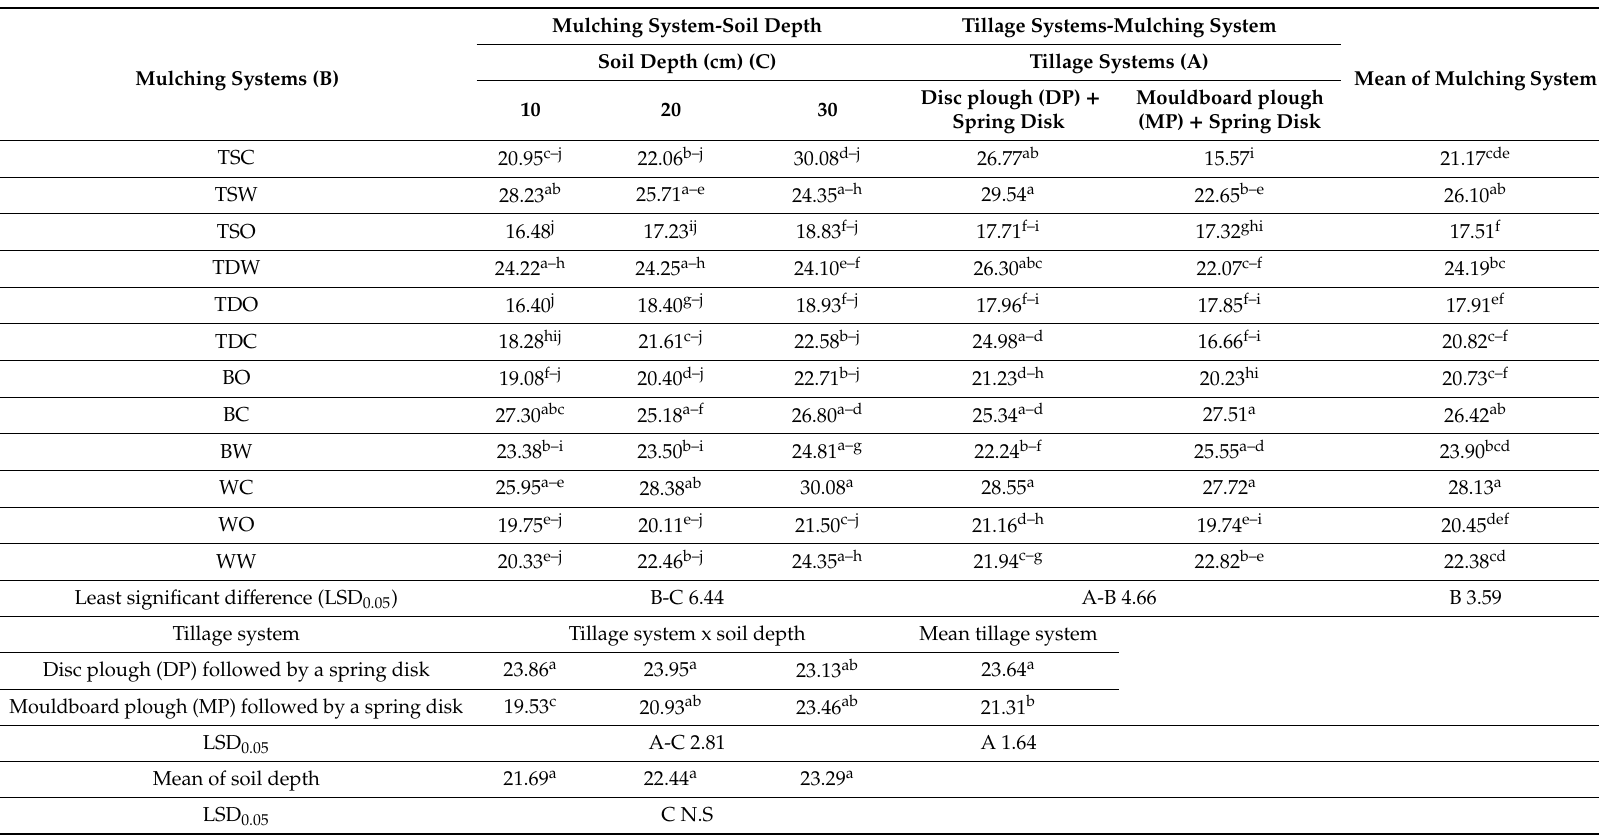
Table 7. Mean of the specific energy consumption (Q con ; kJ kg -1 ) of the DES at di ff erent soil depths for the di ff erent soil